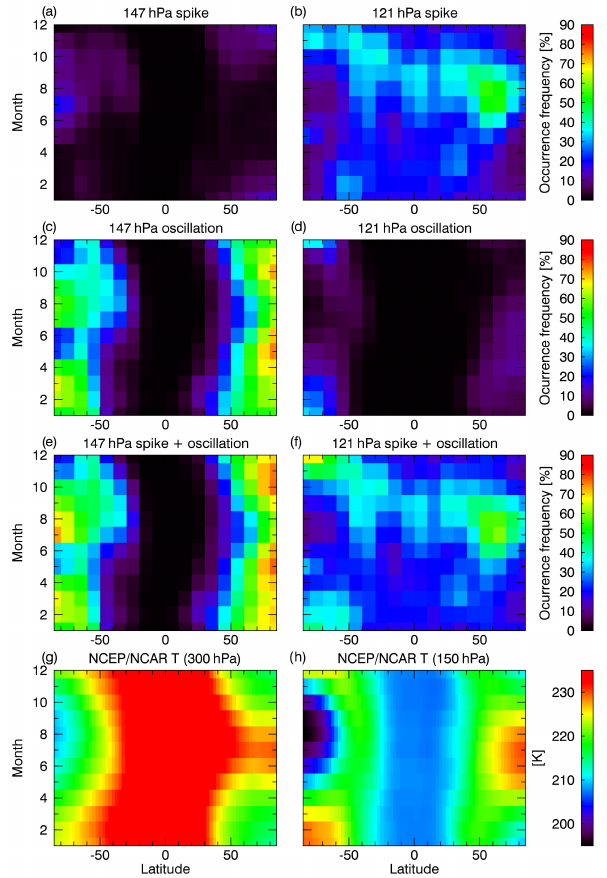
Figure A4. Top rows: occurrence frequency statistics for the four types of Aura MLS UTLS WV oscillations identified. Bottom row: NCEP/NCAR reanalysis of 1981–2010 climatological mean zonal-mean temperature at 300 and